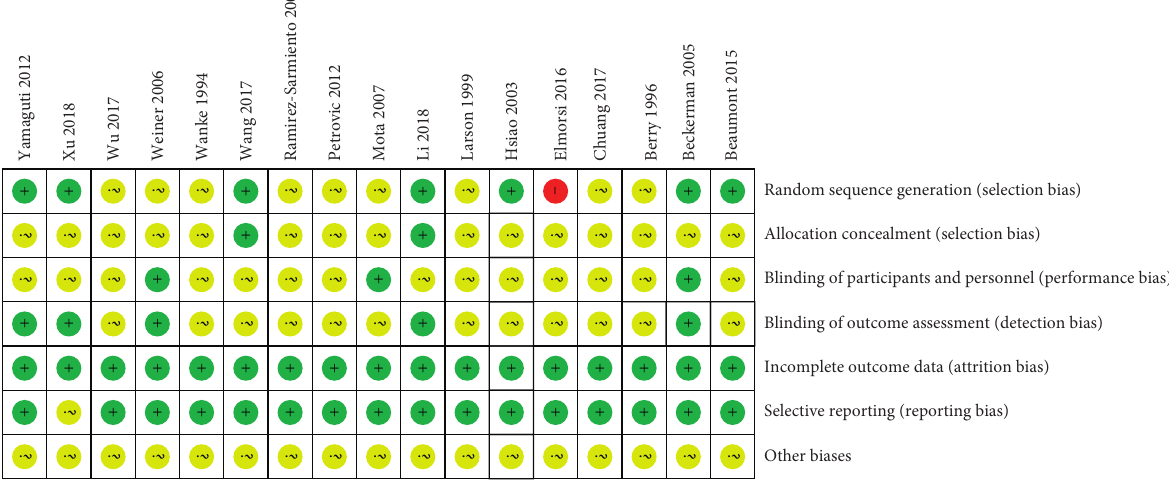
Figure 3: Risk of bias summary: review authors’ judgements about each risk of bias item for each included